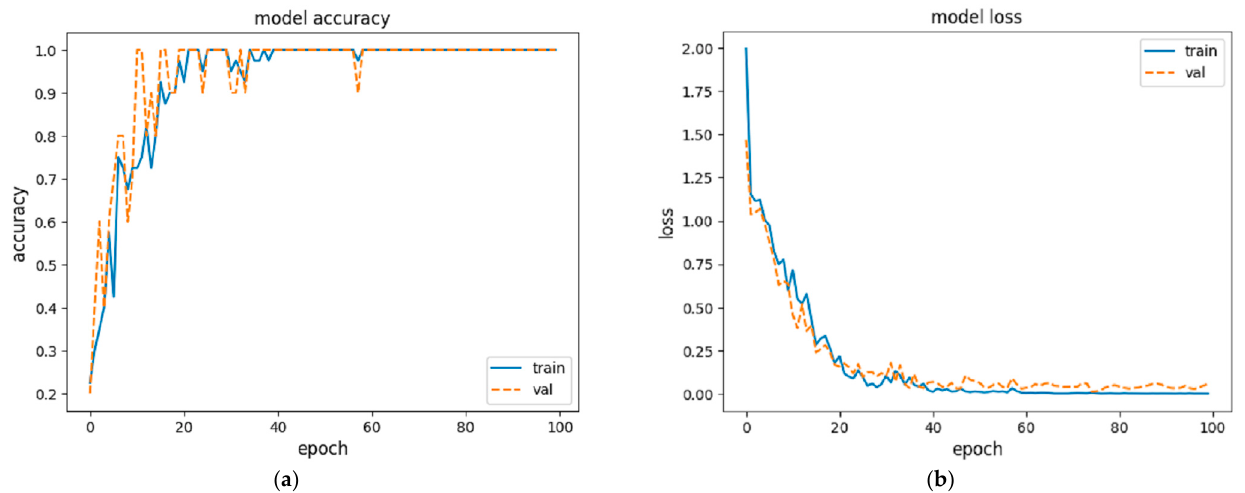
Figure 10. ( a ) Accuracy and ( b ) loss curves over 100 epochs of CNN training.